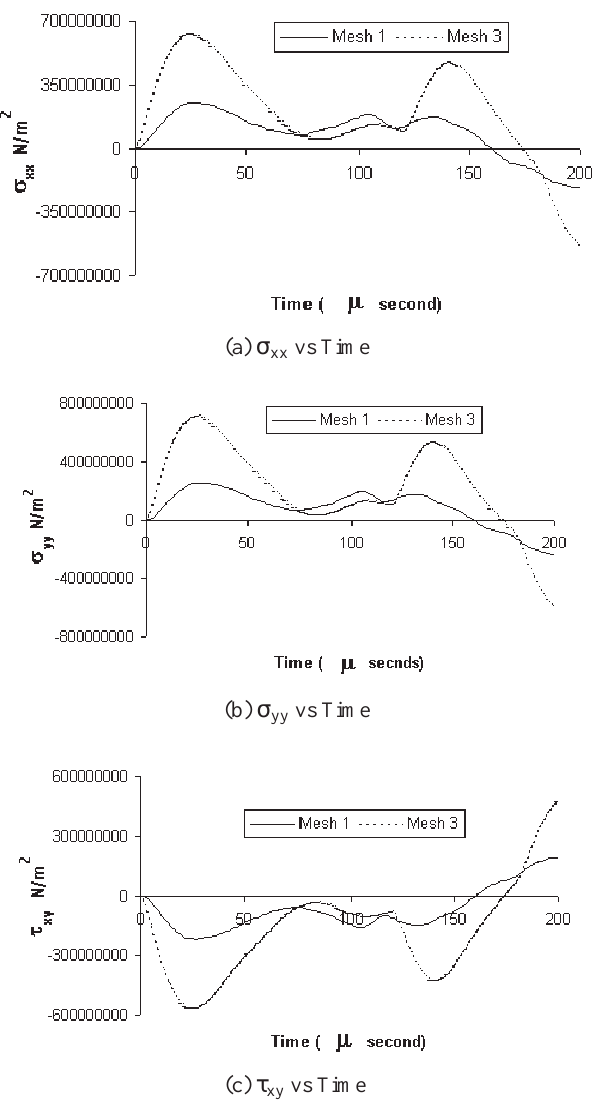
Fig. 10. Variation of stresses near the point of contact with different meshes vs